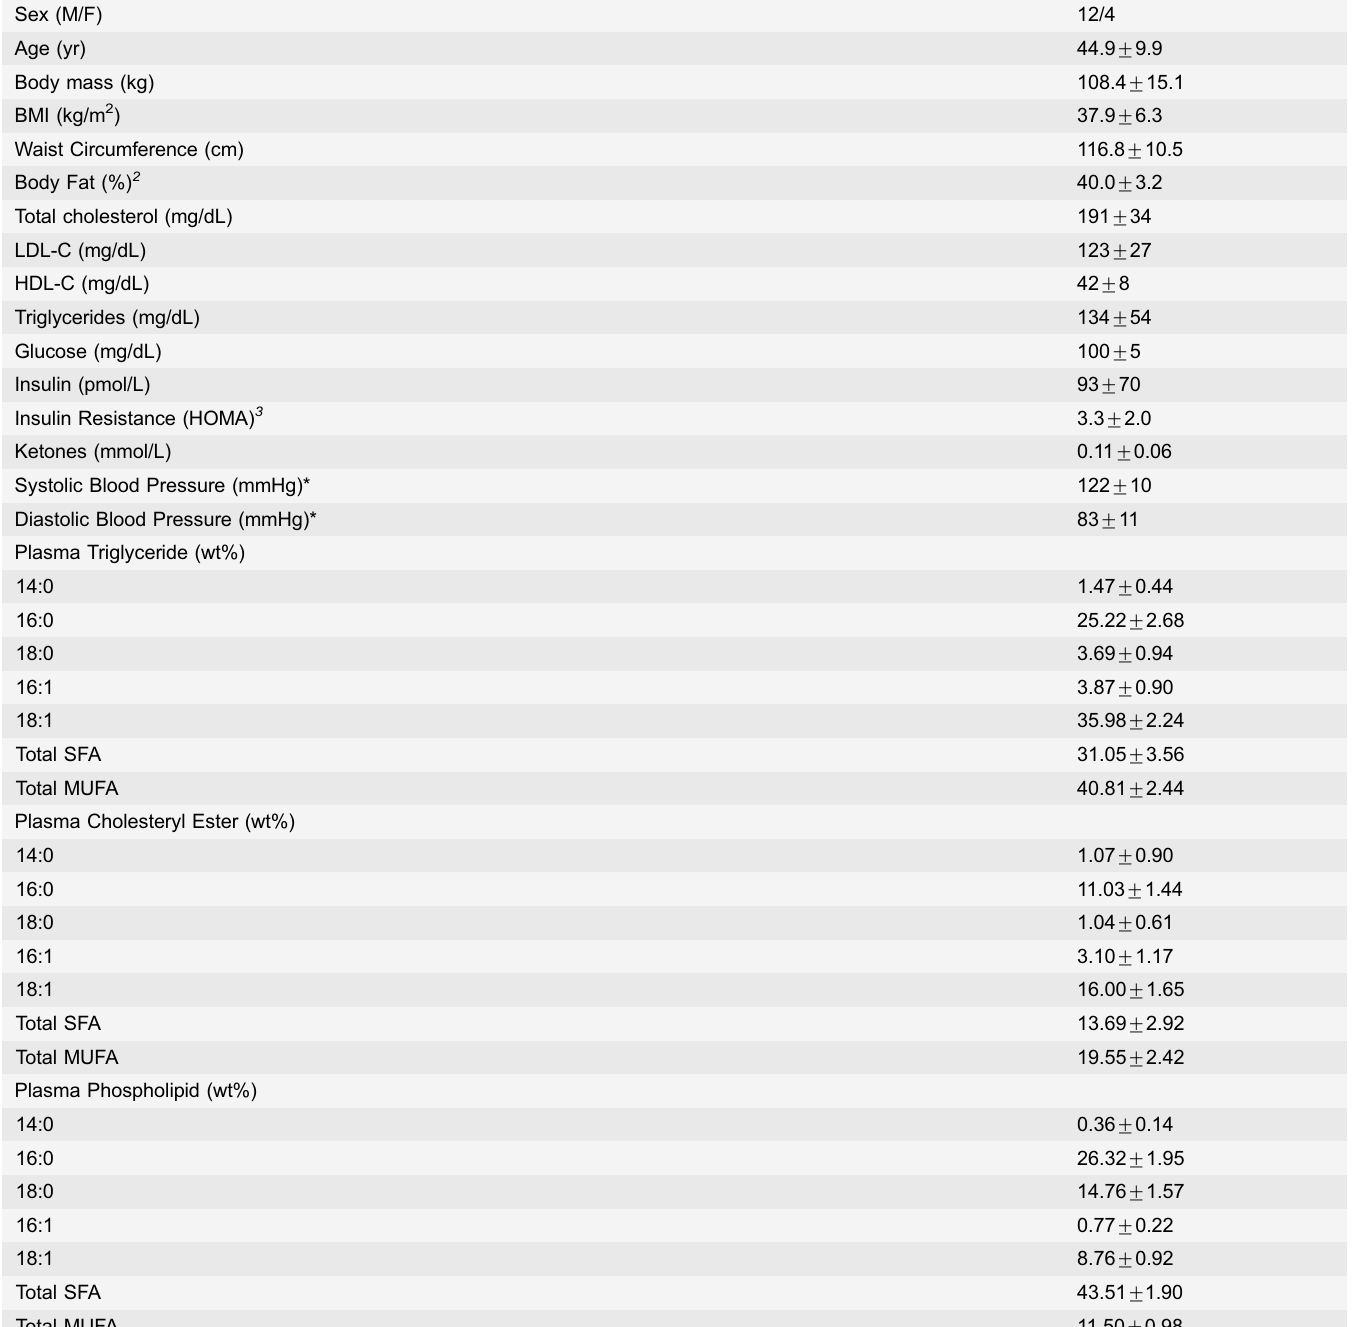
Table 1. Baseline subject characteristics 1